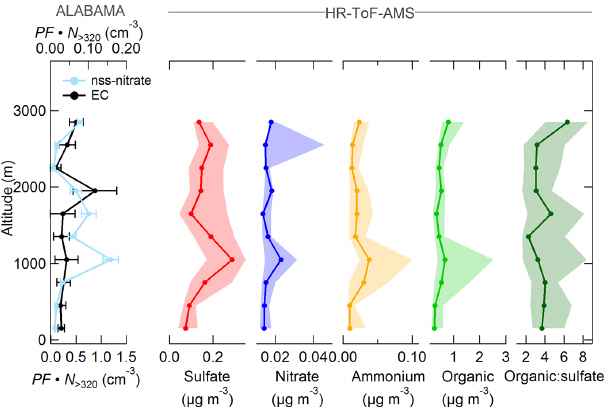
Figure 15. Vertically resolved aerosol composition measured by the ALABAMA and by the HR-ToF-AMS (indicated on the top side) during the southern air mass period. Note the different scales. The left panel represents the scaled ALABAMA number concentration (PF · N > 320 ) with the top axis referring to EC-containing particles (black) and bottom axis referring to nss-nitrate-containing particles (light blue). The right panels represent each median (solid line with marker) and interquartile range (shaded area) of the HR-ToF-AMS mass concentrations of sulfate (red), nitrate (blue), ammonium (or- ange), organic matter (light green), and the organic-to-sulfate ratio (dark green). Uncertainty analyses are given in Sect.